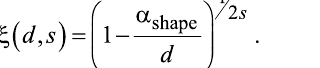
As a further example for theoretically derived values for the surface energy γ , Figure 5 displays the surface energy of gold nanoparticles as a function of the particle diameter [26]. These values were obtained using a function of the type of Equation 6.